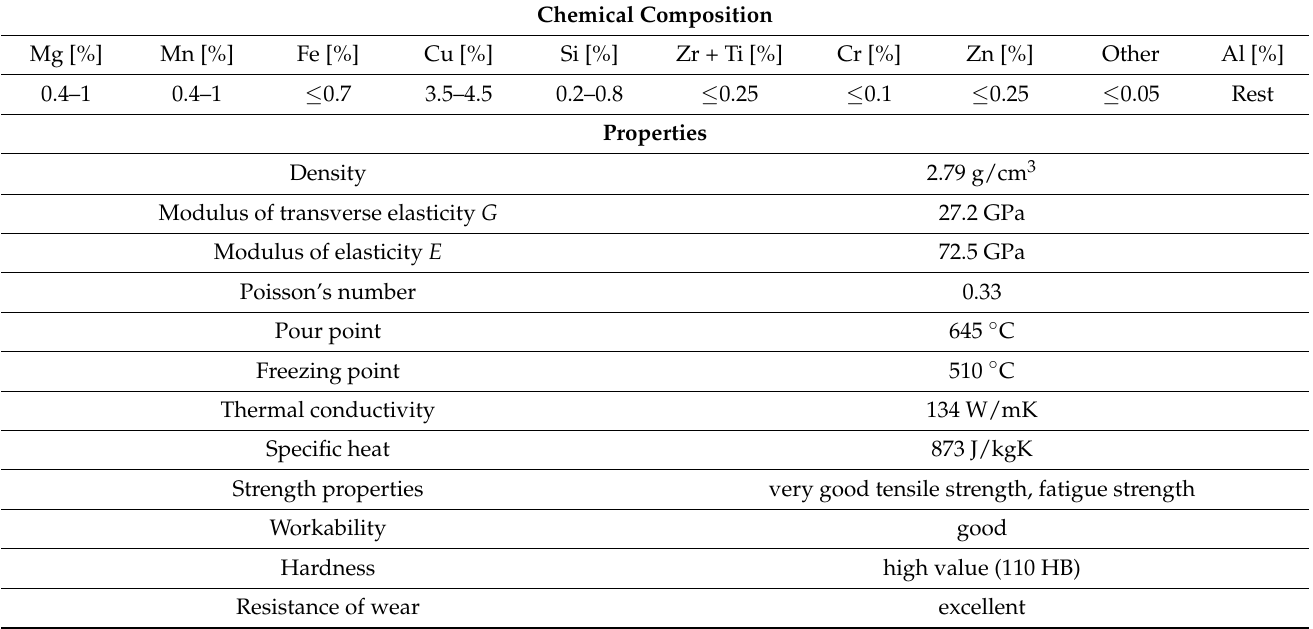
Table 2. Chemical composition and properties of aluminium disc EN